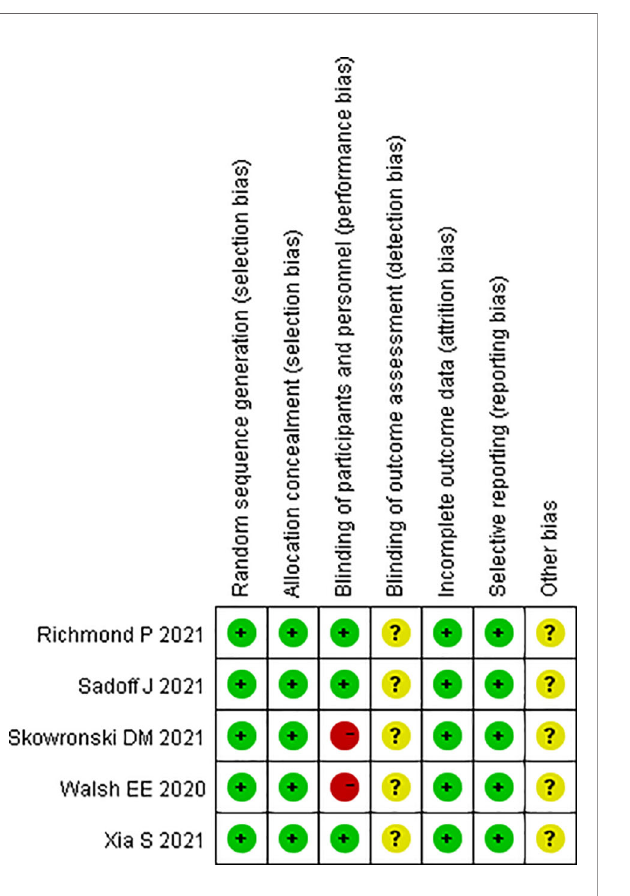
FIGURE 6 | Summary chart of bias